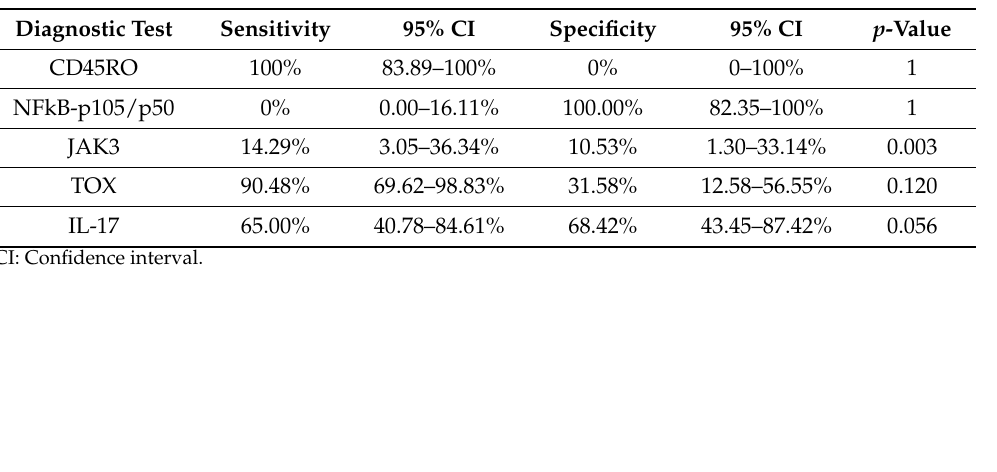
Table 1. Sensitivity and specificity of each immunohistochemical stain in the diagnosis of mycosis fungoides. p -value indicates the statistical difference from control